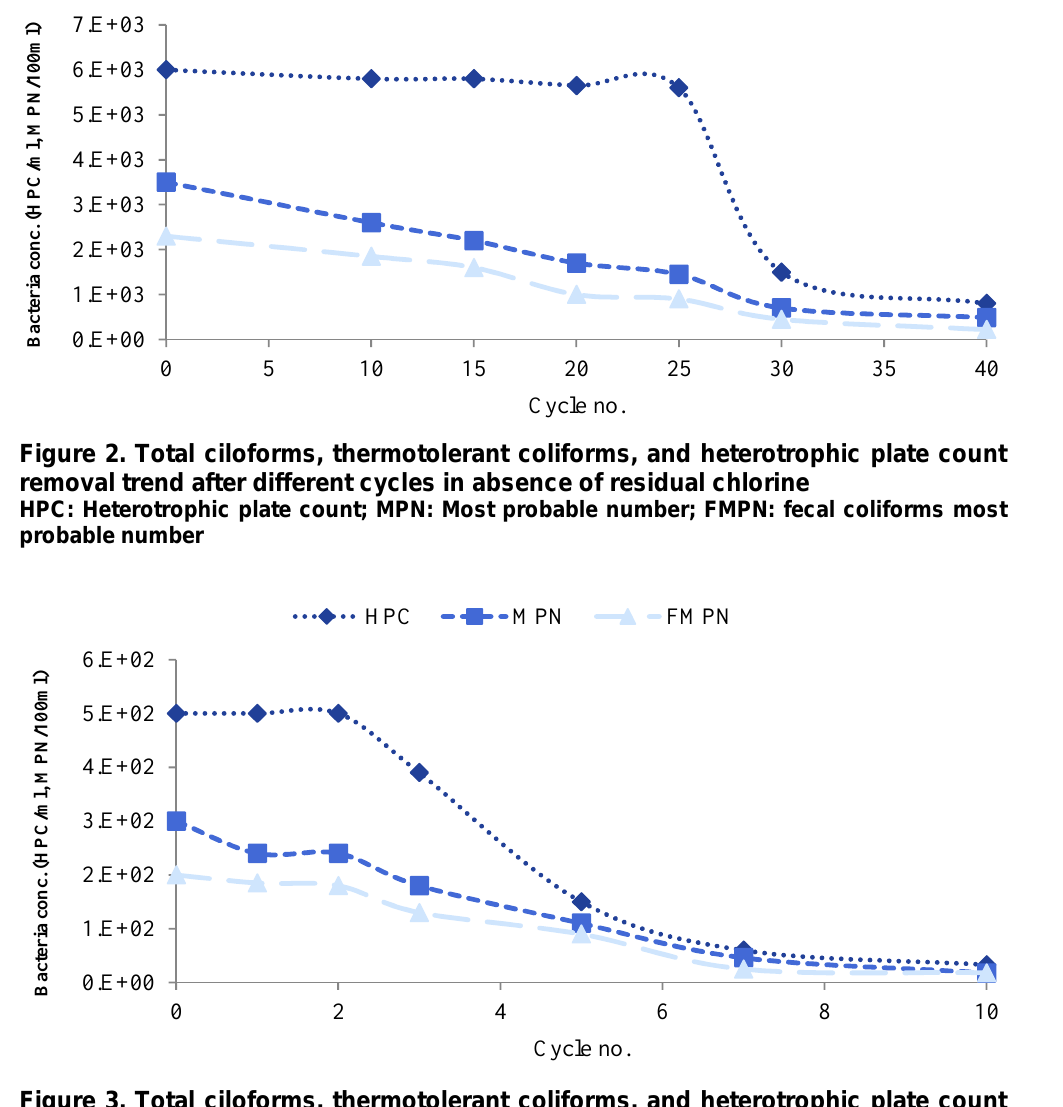
Figure 3. Total ciloforms, thermotolerant coliforms, and heterotrophic plate count removal trend after different cycles in the presence of residual chlorine HPC: Heterotrophic plate count; MPN: Most probable number; FMPN: fecal coliforms